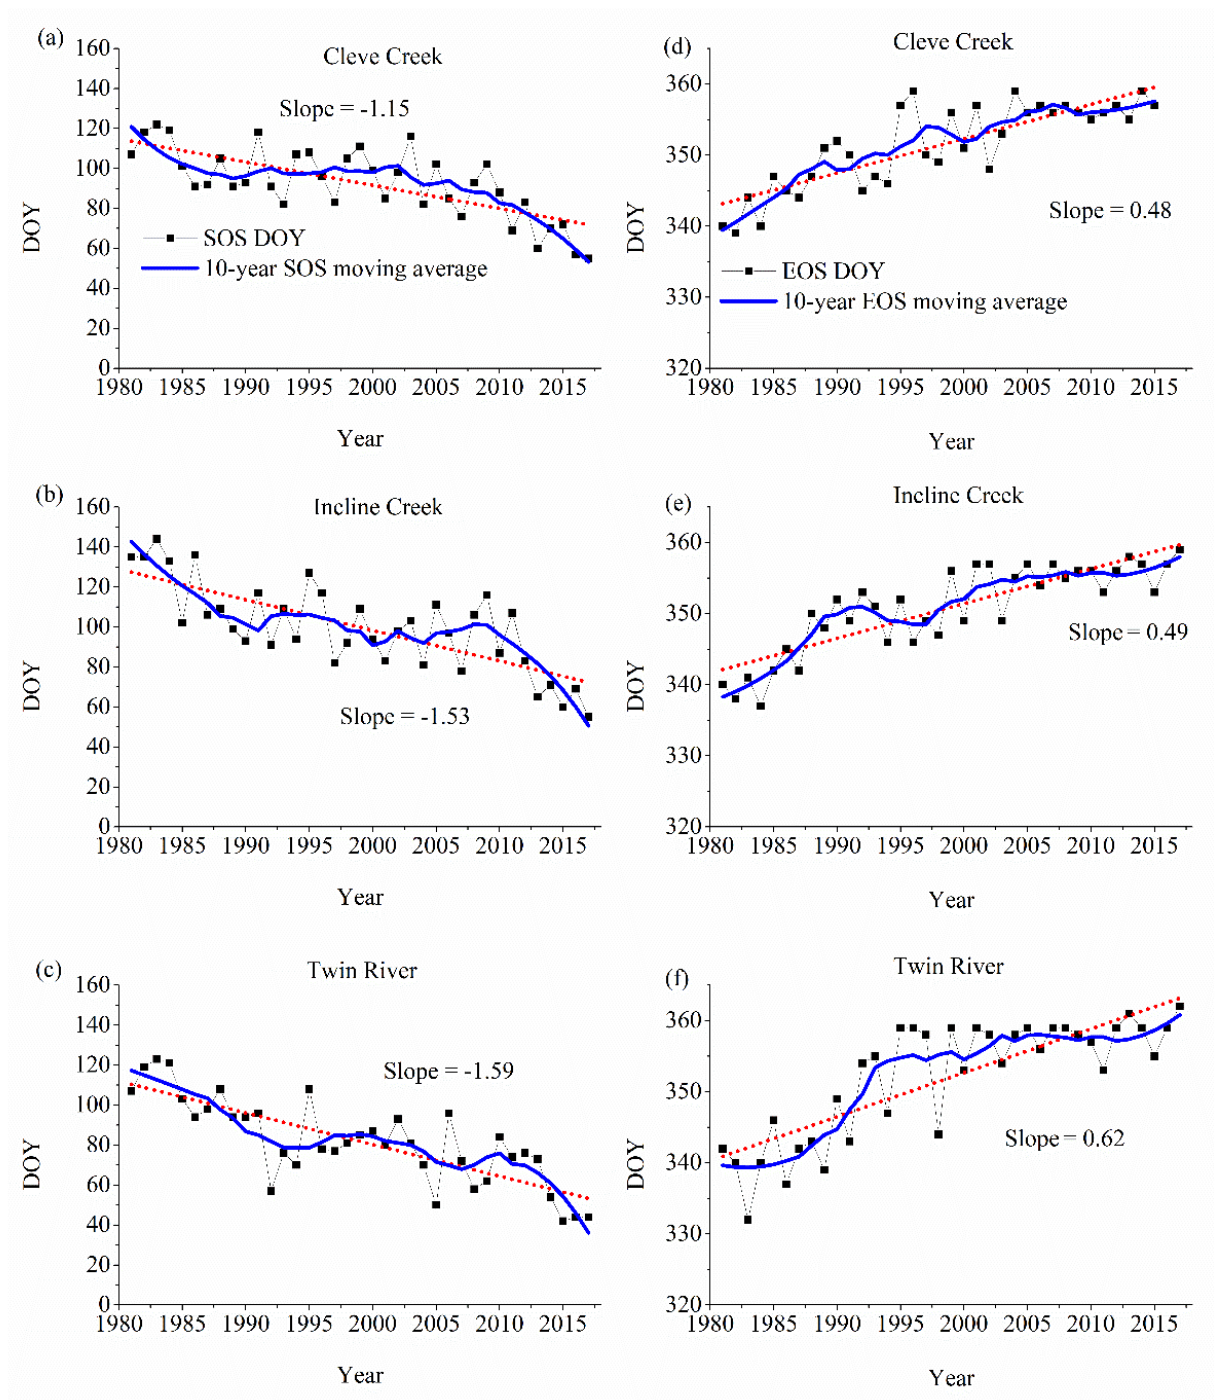
Figure 7. Start of growing season (SOS) ( a – c ) and end of growing season (EOS) ( d – f ) in the three watersheds, where DOY denotes the day of year.